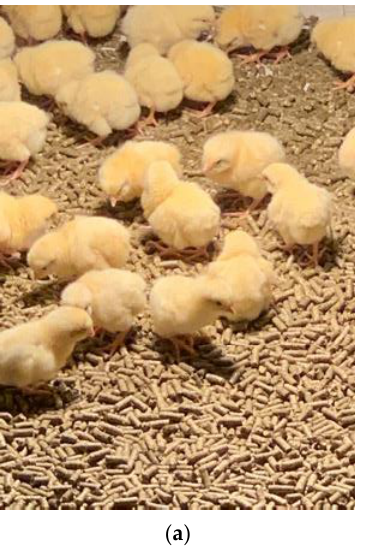
Figure 2. Experimental setting — 1st day of bedding materials use by animals: ( a ) pelletised materials containing parts of medicinal plants; ( b ) straw chaff (control).